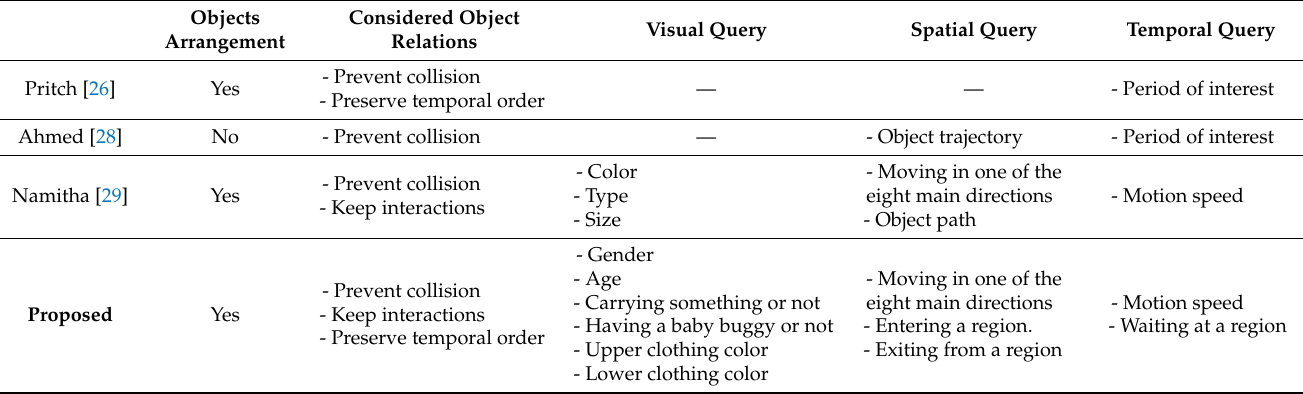
Table 4. Evaluation of the proposed and conventional methods.